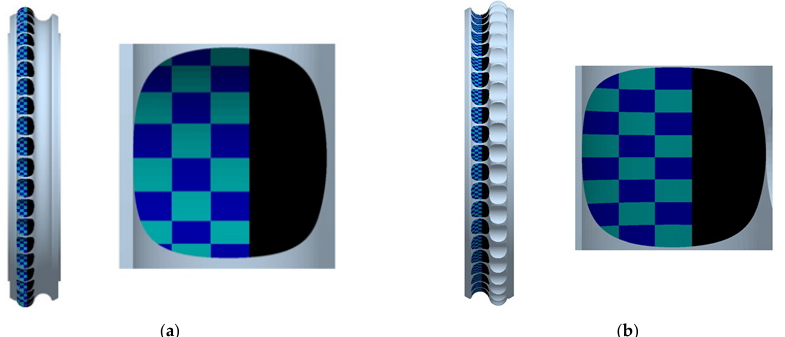
Figure 4. The location of the measuring sites on the surface of the forming elements: ( a ) cavities; ( b ) groove.